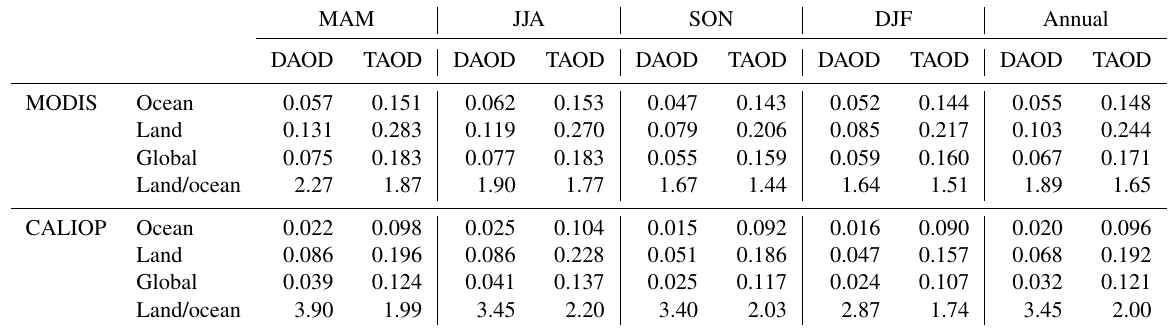
Table 4. Global (60 ◦ S–60 ◦ N) seasonal mean DAOD and TAOD based on MODIS and CALIOP (2007–2019) dust retrievals. Since Earth is a sphere, grid-cell surface area decreases toward the poles. We weight each grid-cell surface area into ocean, land, and global DAOD